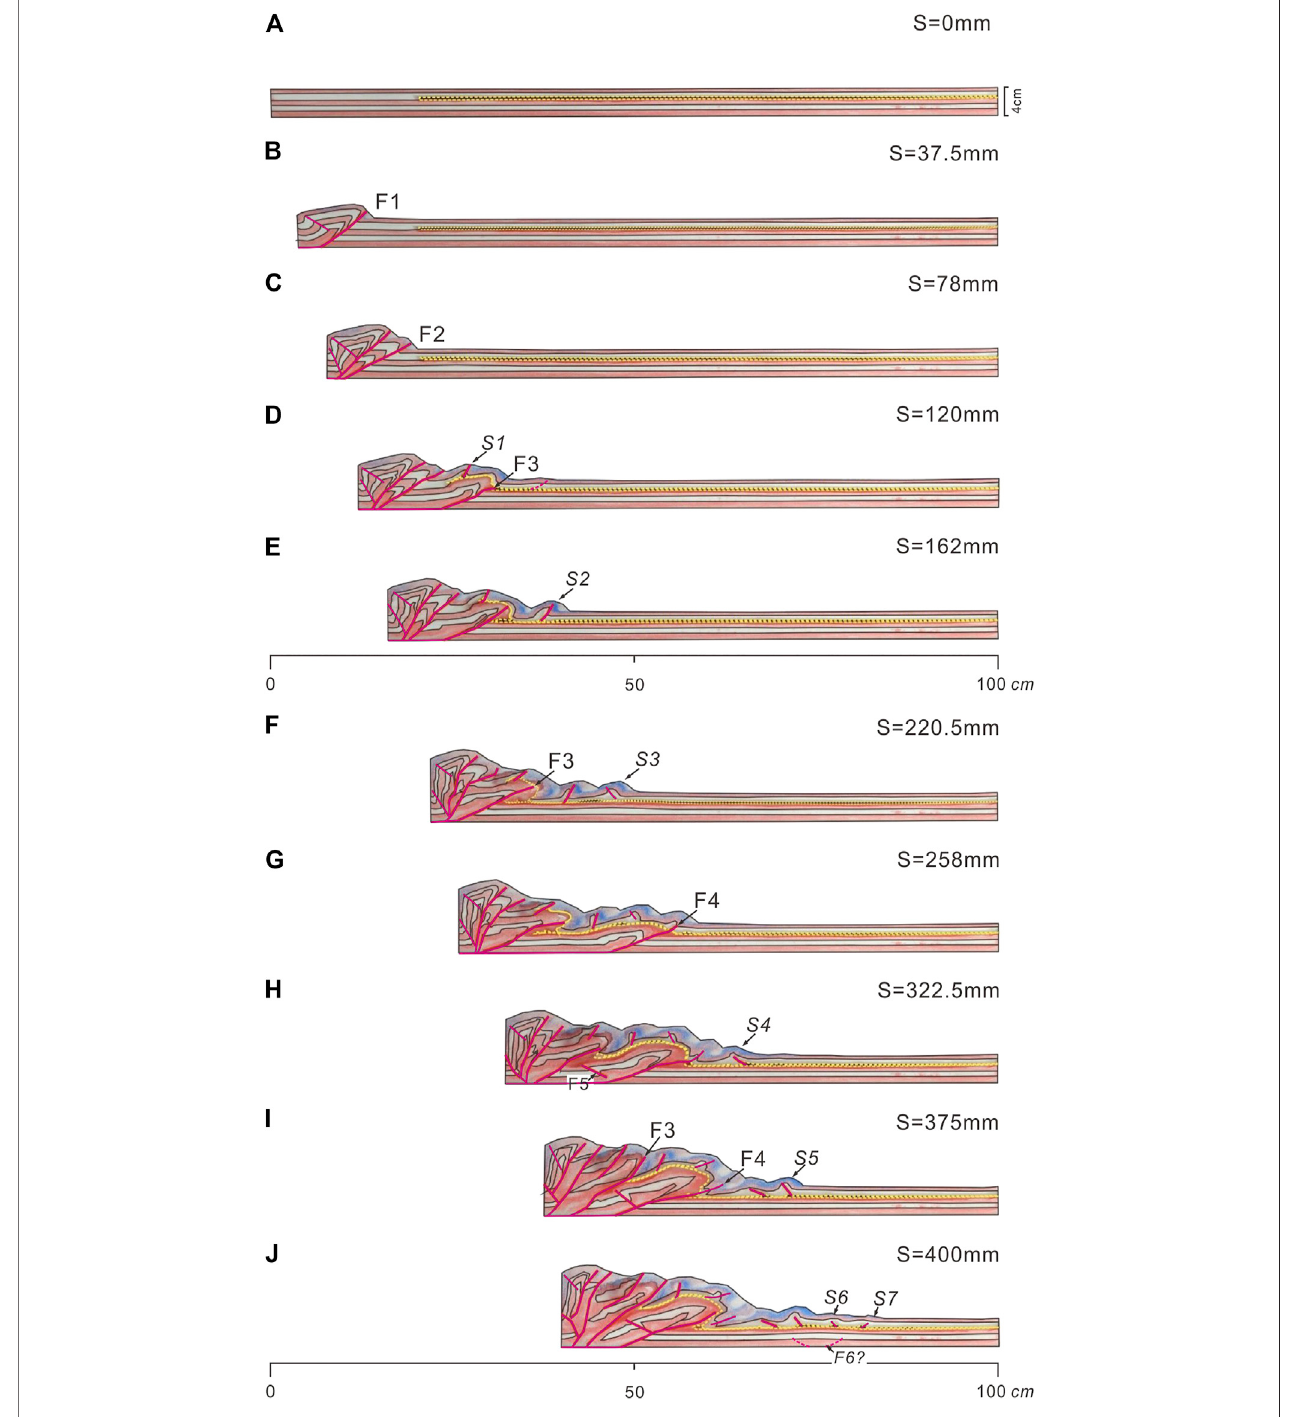
FIGURE 5 | Evolutionary stages of Exp. M1 that contains no MD. The yellow dash line outlines the viscous SD. On the base of the model, a frictional BD was also added. Uppercase letters S and F are used to indicate Folds involving the shallow structural level (above the SD) only and thrusts nucleated from the basal décollement. (A – C) early stages before the SD was affected by shortening; Experimental shortening produced a thrust wedge against the mobile backstop (not shown here). (D – J) Deformation started its propagation within the shallow and deep structural levels (separated by SD), respectively. A fast, in-sequence development of shallower folds occurred synchronous with deep faulting. Shortening in deep was localized in fewer faults in comparison to the shallow, resulting in a delay in the migration of the deep deformation front toward the foreland.